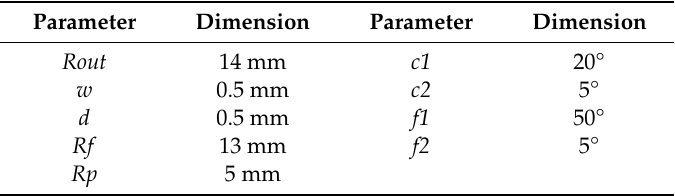
Table 2. Dimensions of parameters of the proposed tag